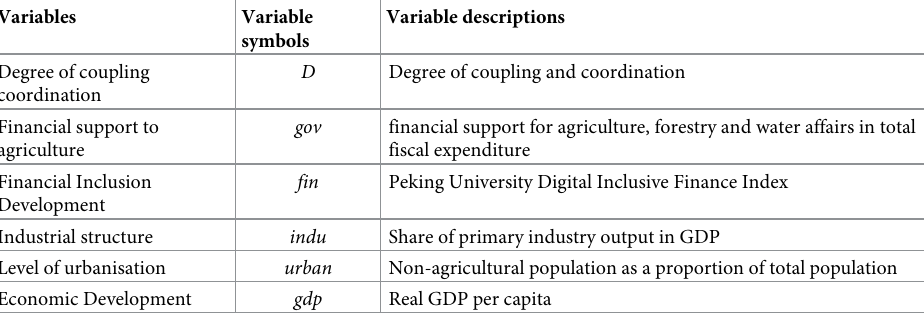
Table 4. Variables and descriptions.